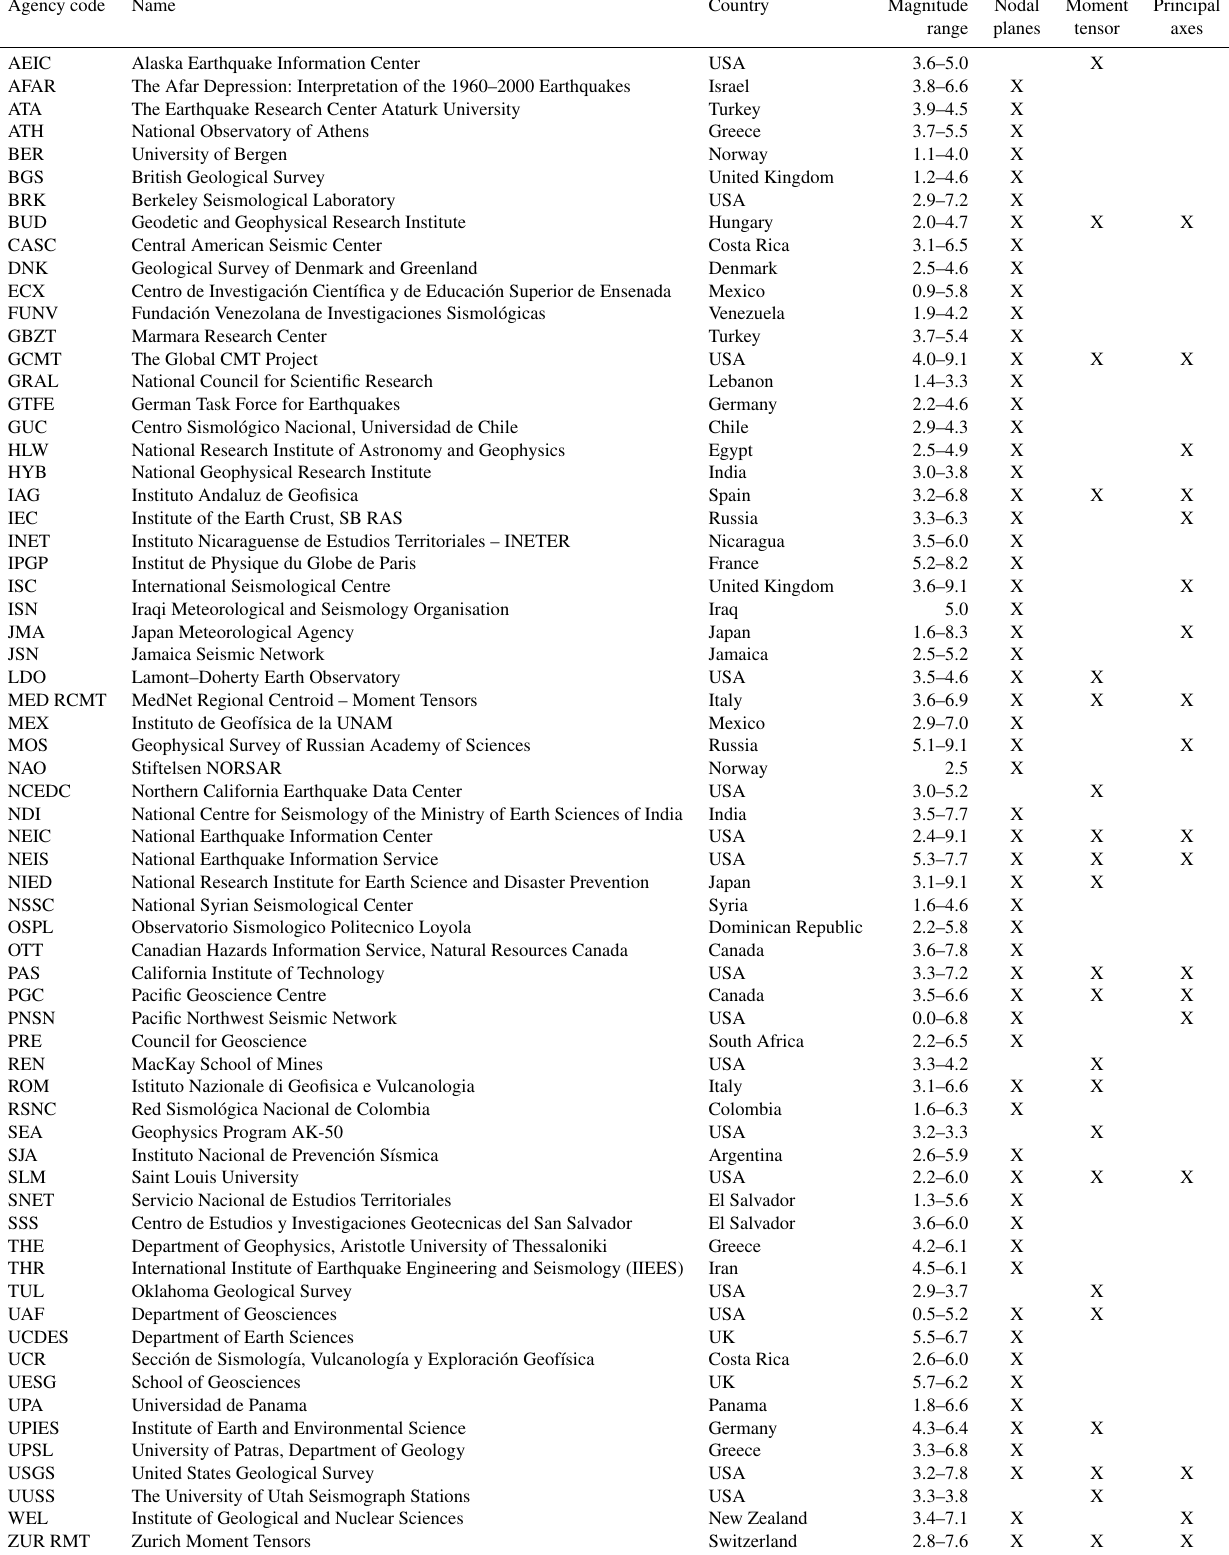
Table 1. Agencies reporting source mechanism solutions at the ISC for the time period from January 1964 to December 2018. The cross symbol (X) denotes the type of parametric data that is reported from each agency to the ISC. Agency